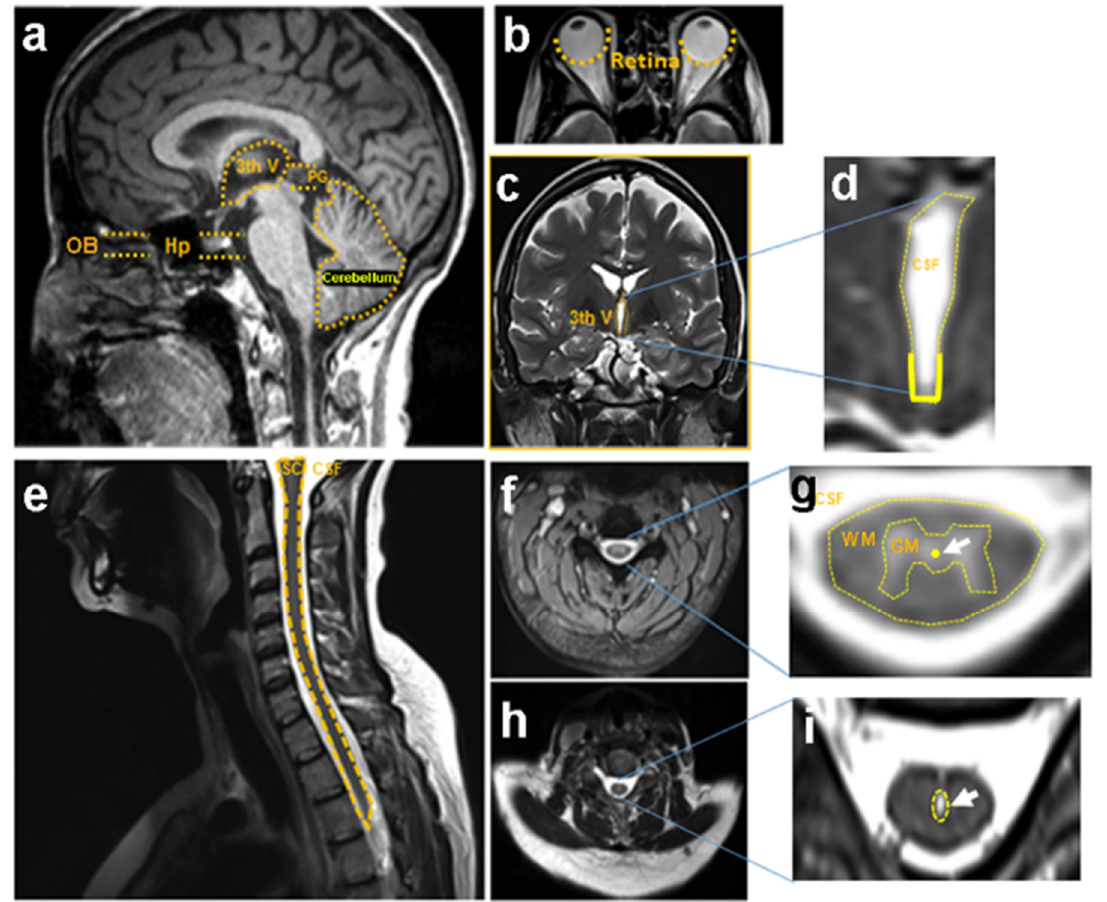
Figure 1. Locations of the aldynoglia cell subpopulation in the human CNS. The magnetic resonance imaging show neural niches for aldynoglia in the brain ( a – d ) and spinal cord ( e – i ): olfactory bulbs, hypophysis, third ventricle, pineal gland, cerebellum in ( a ), and both retinas ( b ). A coronal section of MRI showing the lateral ventricles ( c ) with enlarged third ventricle filled with cerebrospinal fluid ( d ), high presence of aldynoglia cells in the floor, and the lateral walls are marked. Spinal cord as a broad zone for aldynoglia, sagittal MRI section of the cervical zone of SC floating in CSF is shown ( e ). The axial section at C7 level ( f ) is enlarged showing the medullar channel with CSF surrounding white matter and grey matter, which contains aldynoglia cells ( g ). Arrows pointed to the location of resident aldynoglia in the ependyma of a normal individual ( g ) or activated aldynoglia in widened ependyma with hydromyelia in the spinal cord of patient ( i ). 3th V, third ventricle; C7, seventh vertebral cervical level; CSF, cerebrospinal fluid; GM, grey matter; Hp, hypophysis; MRI, magneting resonance imaging; OB, olfactory bulbs; PG, pineal gland; SC, spinal cord; WM, white matter.